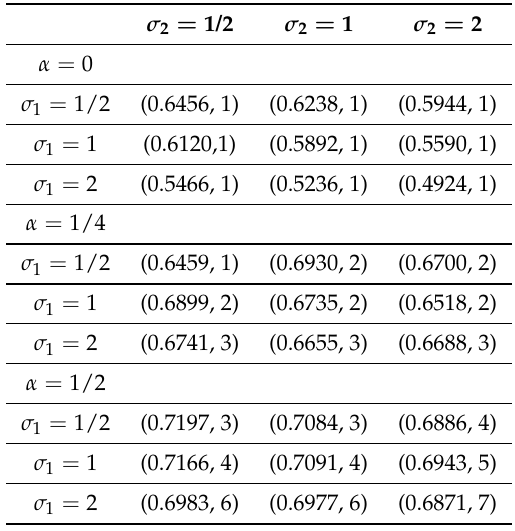
Table 7. Effect of the relative importance of the second signal to the DMs on the effectiveness